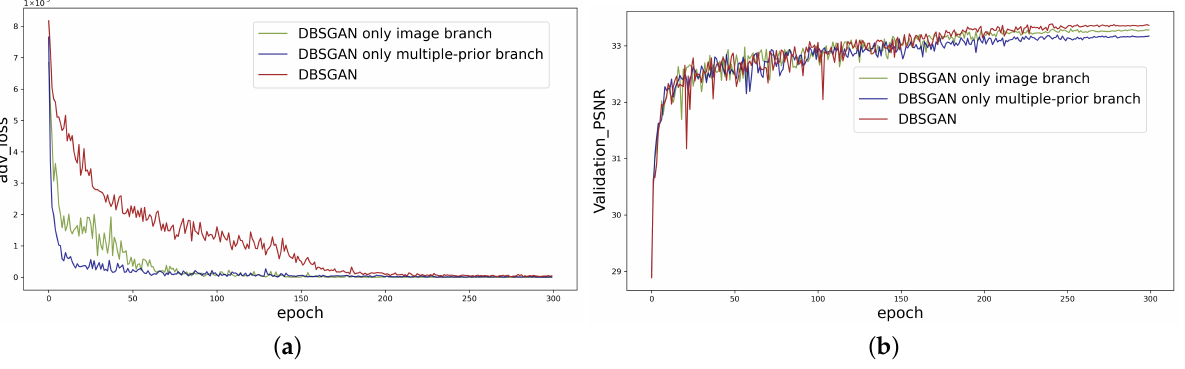
Figure 4. The comparison of adversarial loss between our DBSGAN and the simple GAN with only one branch. ( a ) The convergence performance of adversarial loss in each epoch. ( b ) The PSNR of the validation set in each